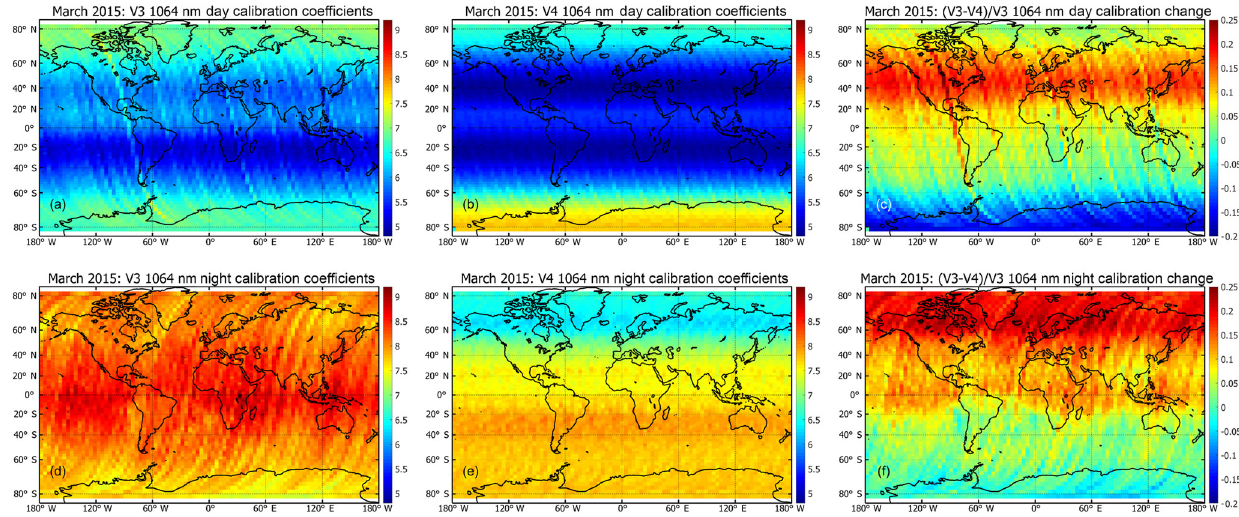
Figure 19. V3 and V4 calibration coefficients for March 2015. Panels (a) through (c) show daytime mean 1064nm calibration coeffi- cients (units: km − 3 srJ − 1 count); V3 is shown in panel (a) , V4 in panel (b) , and their ratios ((V3–V4) / V3) in panel (c) . Similarly, panels (d) through (f) show nighttime mean 1064nm calibration coefficients (units: km − 3 srJ − 1 count), with V3 shown in panel (d) , V4 in panel (e) , and their ratios (V3 / V4) in panel (f) .